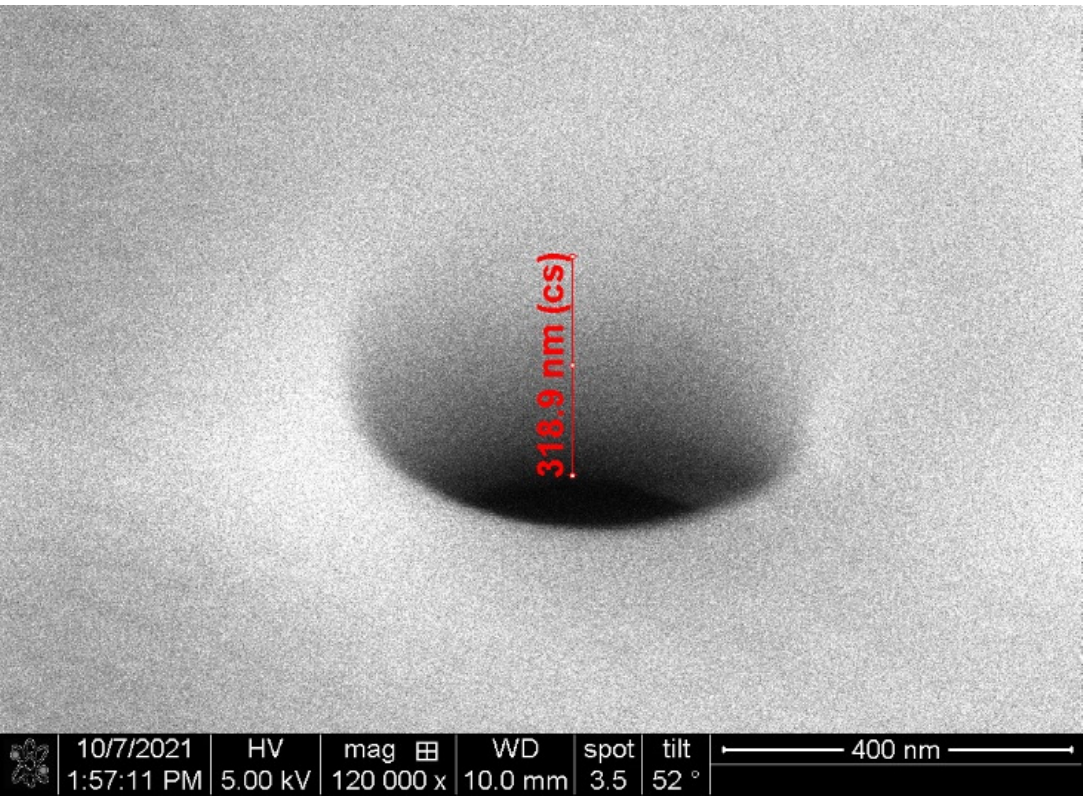
Figure 1. Scanning electron micrograph (SEM) of a solid-state pore drilled into a nanomembrane on an optical manipulation device using a focused ion beam (FIB).